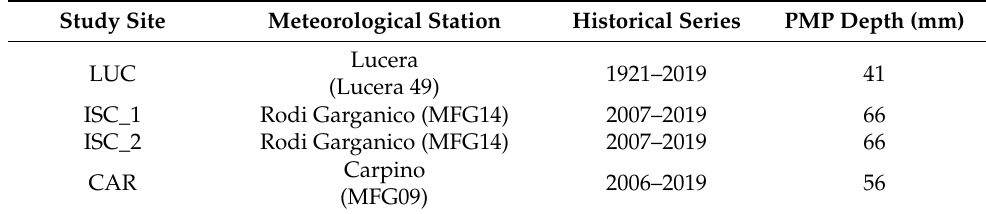
Table 4. Rainfall